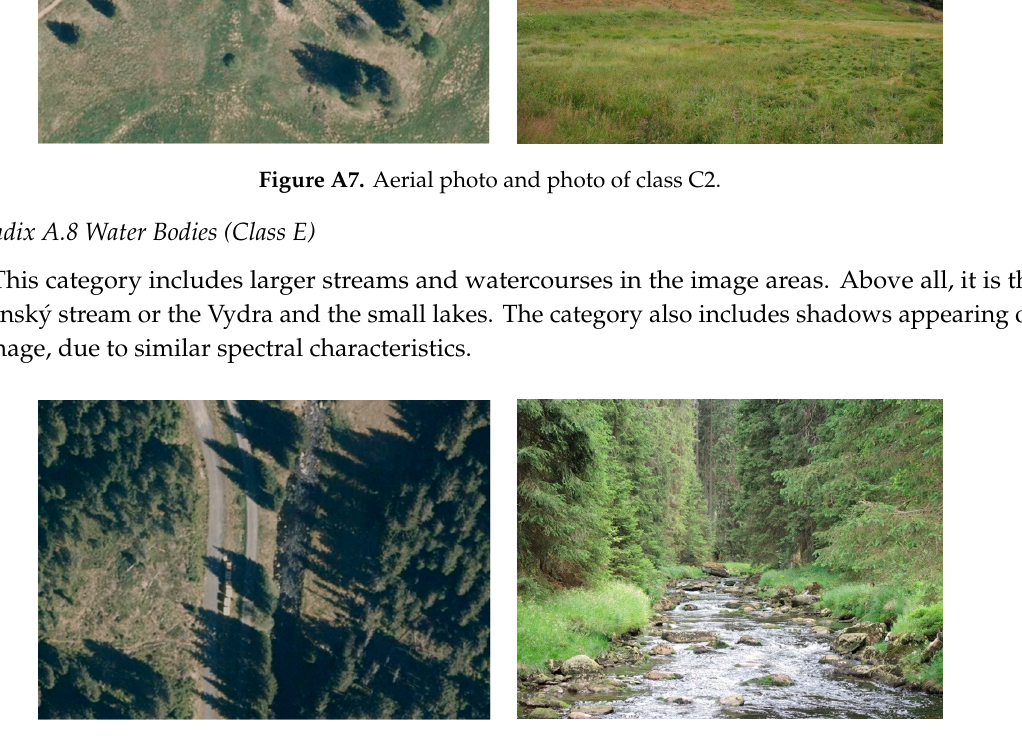
Figure A8. Aerial photo and photo of class E.